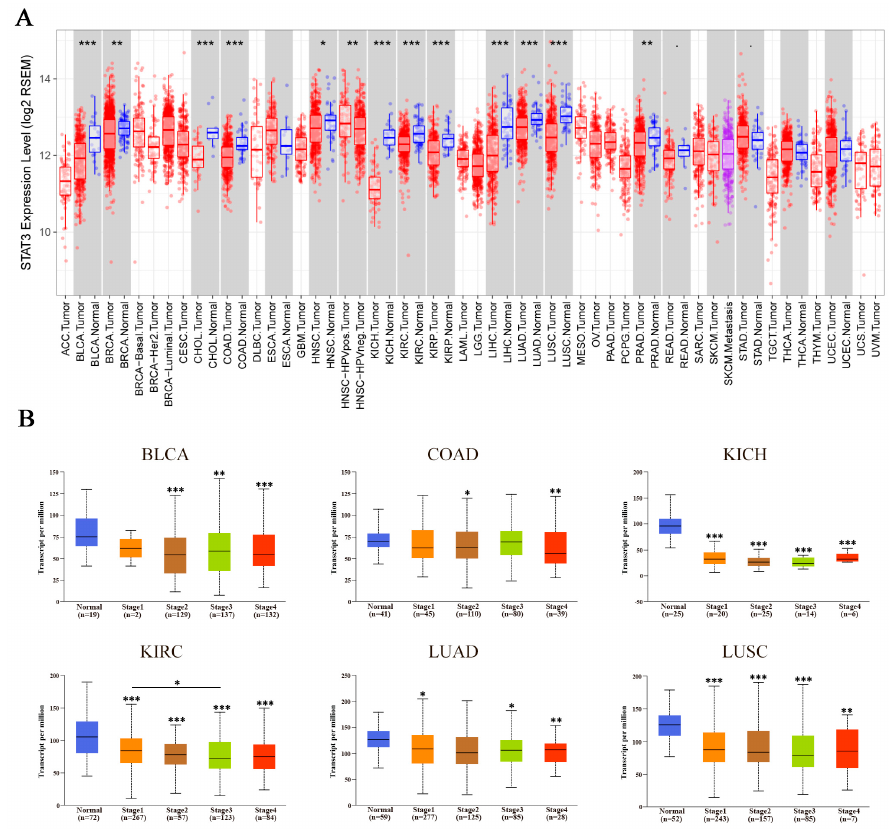
Figure 1. The expression levels of signal transducer and activator of transcription 3 (STAT3) along with the pathological stage in cancer. (A) The mRNA expression levels of STAT3 in different cancer types were explored by TIMER. (B) The correlation between the expression of STAT3 and the pathological stage in bladder urothelial carcinoma (BLCA), colon adenocarcinoma (COAD), kidney chromophobe (KICH), kidney renal clear cell carcinoma (KIRC), lung adenocarcinoma (LUAD), and lung squamous cell carcinoma (LUSC) was explored by UALCAN database. The first layer asterisk above the error bar represents a comparison to the normal group, and the secondary layers asterisk above a line represents the comparison between corresponding groups that were covered by the line. * p < 0.05, ** p < 0.01, *** p < 0.001.